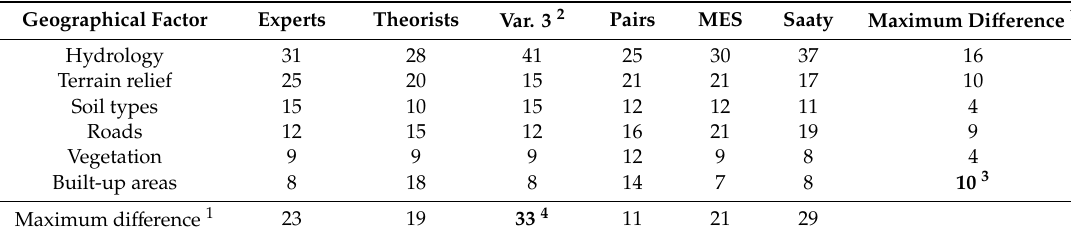
Table 2. Weights of individual factors and their di ff